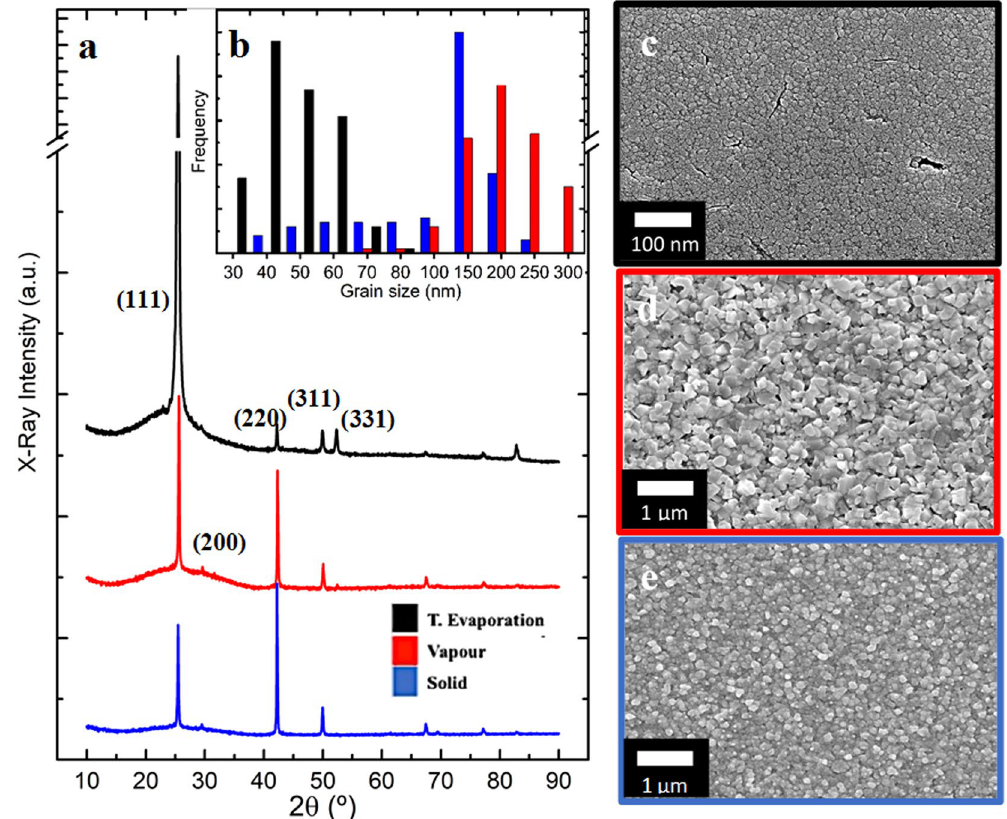
Figure 1. ( a ) X-Ray Diffraction (XRD) spectra and SEM images of CuI obtained by three methods: ( c ) Thermal evaporated; ( d ) Vapour iodination; and ( e ) Solid iodination. A histogram with grain size distribution is presented ( b